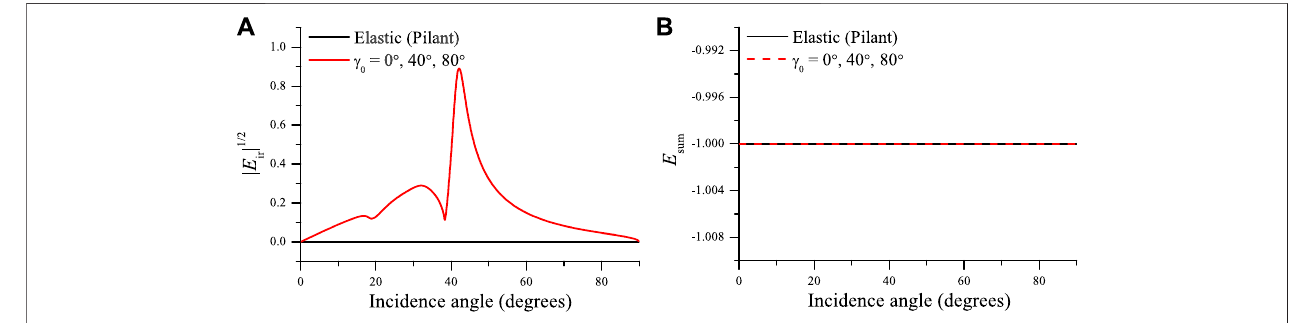
FIGURE 11 | Square root of the interference energy (A) and the sum of the energy ratios (B) (see Figure 8 ).